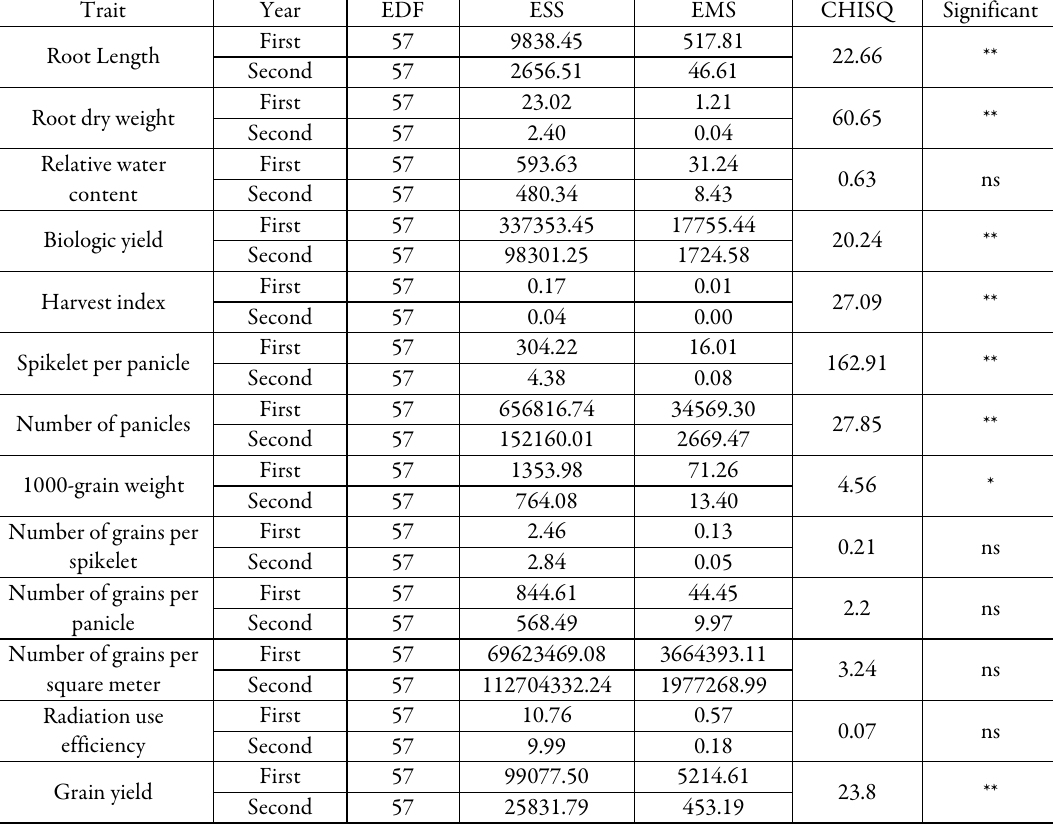
Table 3. Bartlett's test related to different studied traits among wheat genotypes for two crop